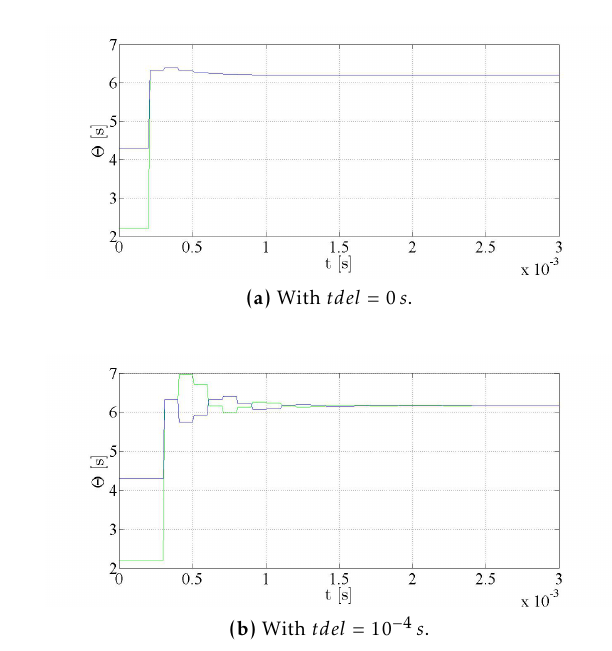
Figure 10. Clock offset convergence behaviors of the two